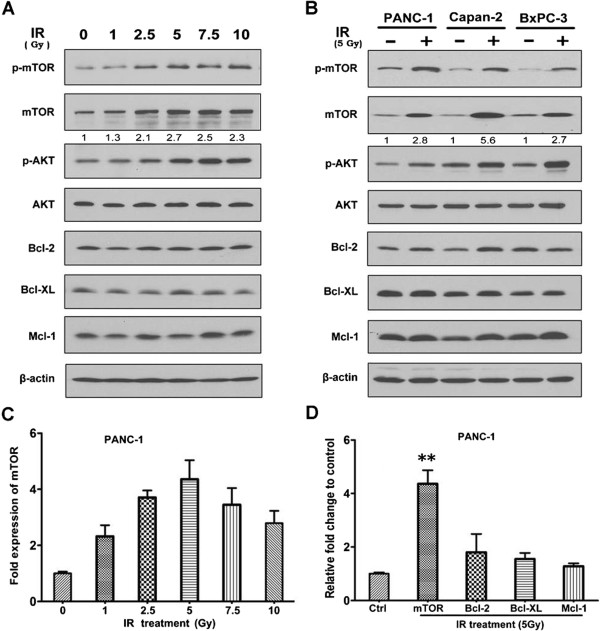
Radiation induces mTOR phosphorylation in association with mTOR upregulation on mRNA and protein levels. (A) PANC-1 cells were treated with indicated doses of IR for 1 h. mTOR, p-mTOR, AKT, p-AKT or Bcl-2 family members were analyzed by Western blot, and the intensity of mTOR expression was quantified with ImageJ software. (B) The above proteins were analyzed in PANC-1, Capan-2 and BxPC-3 cell lines after treated with radiation at 5 Gy. (C) Relatively fold changes of mTOR mRNA were analyzed by RT-PCR in PANC-1 cells. (D) Relatively fold changes of mTOR, Bcl-2, Bcl-XL and Mcl-1 mRNA were analyzed by RT-PCR. GAPDH were used as a blank control. Data are representative of three experiments. Error bars represent as mean± S.D. **, P < 0.01 vs. control.